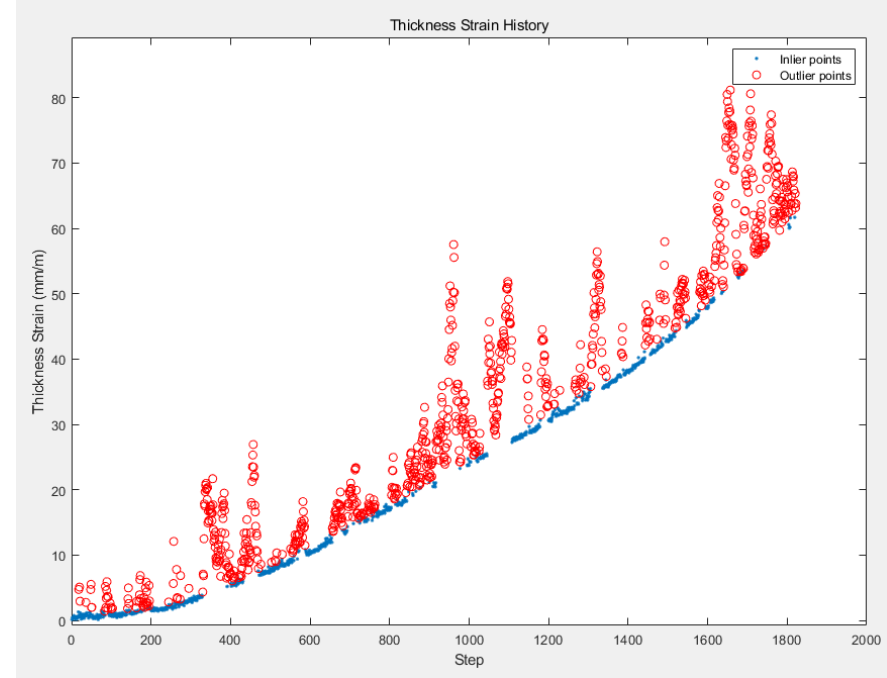
Figure 6. Thickness strain data is classified inlier and outlier.